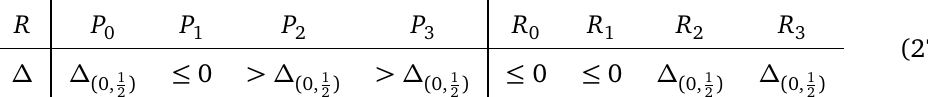
Table 7: Critical exponents ∆ of P σ and R σ in the limit z behave as | z